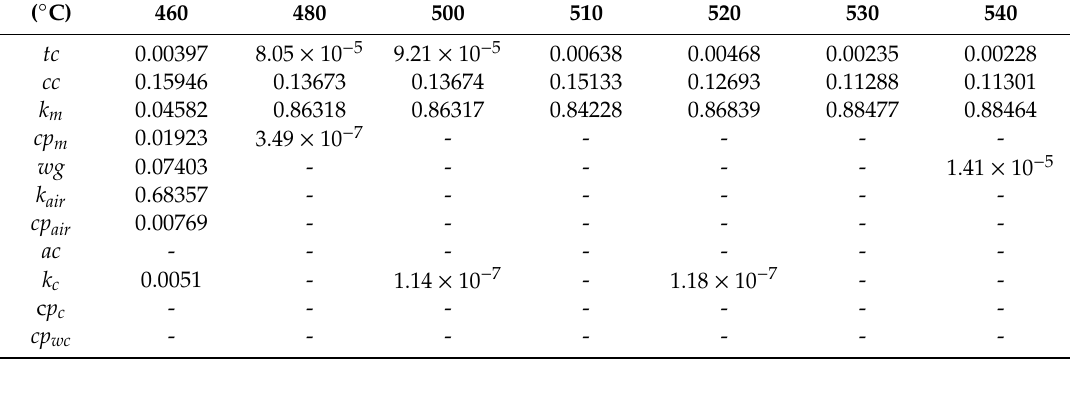
Table 4. Impact factors for the HTC at the casting–mold interface for p < 0.05.